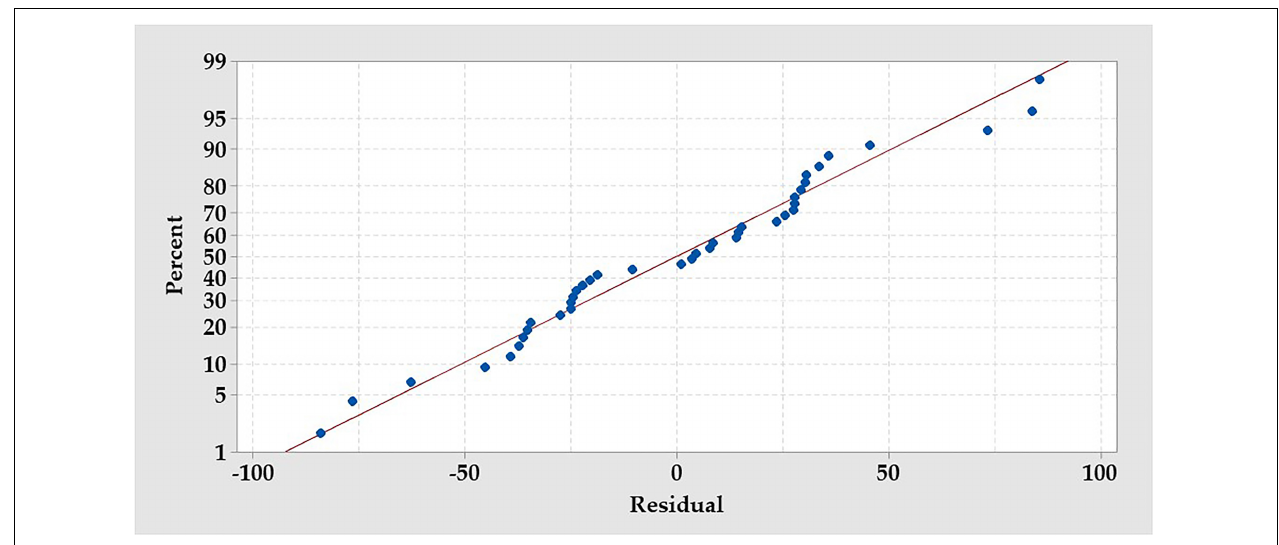
FIGURE 6 | The normal probability plot of the RCCD residuals of the production of the amino acids by B. paramycoides